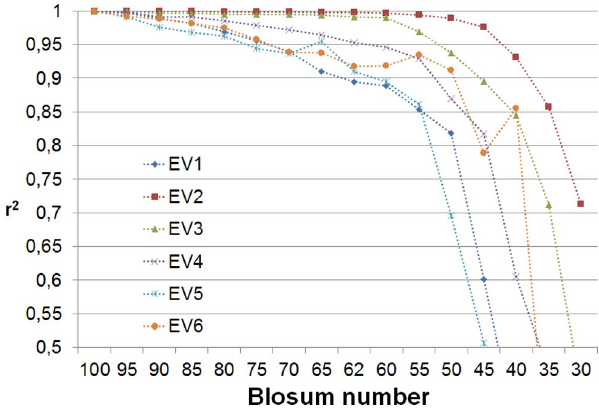
Figure 1. Squares of correlation coefficients between eigen- vectors obtained from B x matrix with the eigenvectors obtained from the B 100